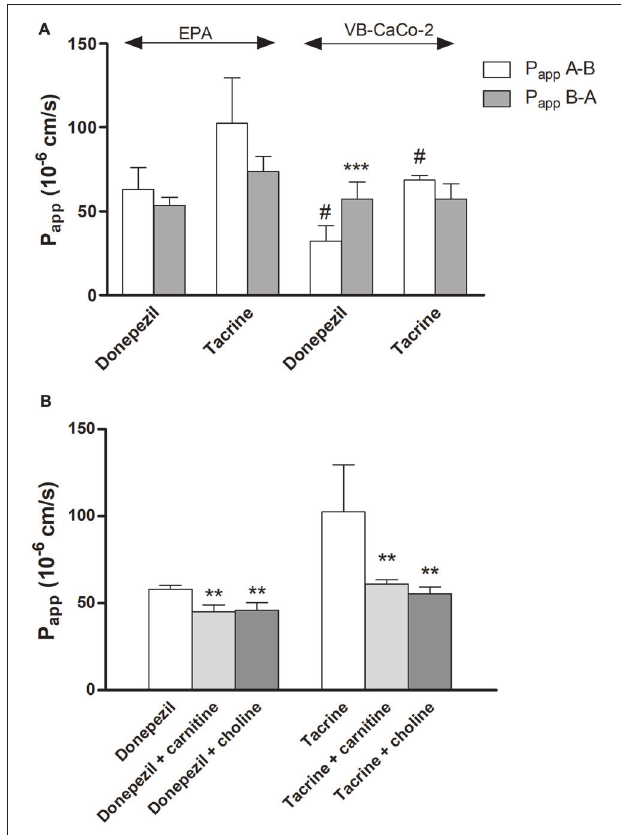
FIGURE 11 | Permeability coefficients (P app ) for donepezil and tacrine on primary rat brain endothelial cell-based BBB model (EPA) and epithelial cell line VB-Caco-2 (A) . Transport of donepezil and tacrine in the presence of choline (50 µ M) and L-carnitine (50 µ M) on the EPA model (B) . Statistics: mean ± SD, n = 4, two-way ANOVA and Bonferroni test; ∗∗ P < 0.01; ∗∗∗ P < 0.001 compared to control; # P < 0.05 compared to